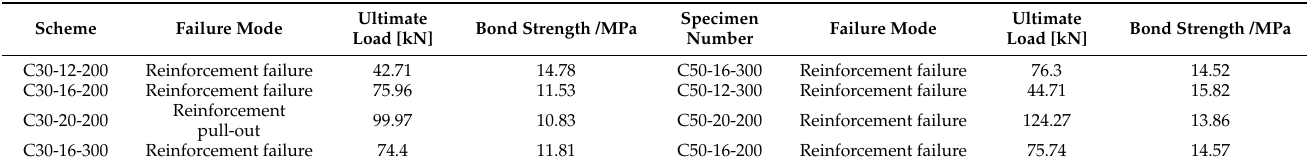
Table 5. Analysis results.